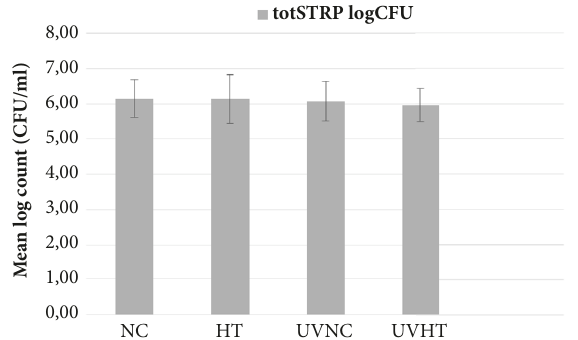
Figure 4: Mean logarithmic CFU counts ( ± SD) of non-mutans streptococciin the plaque collected from the studied materials: Non coated titanium alloy (NC), hydrothermally induced TiO 2 coating (HT), UV treated non-coated titanium alloy (UVNC) and UV treated titanium alloy with hydrothermally induced TiO 2 coating (UVHT).